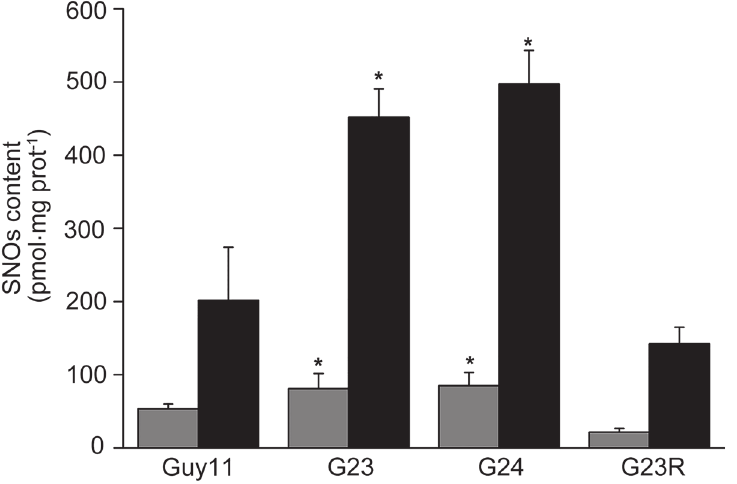
Fig 3. The levels of SNOs in the tested M . oryzae strains. Total intracellular SNOs content in mycelia cultured in liquid CM in the dark at 28°C for 3 days without (gray bar) or with 100 μ M SNP treatment (black bar). The values obtained were compared to a standard curve constructed using GSNO. The results were normalized to the protein content by a Bradford assay. The experiments were performed in triplicate. Error bars represent SD. Asterisks in each data column indicate significant differences at p =